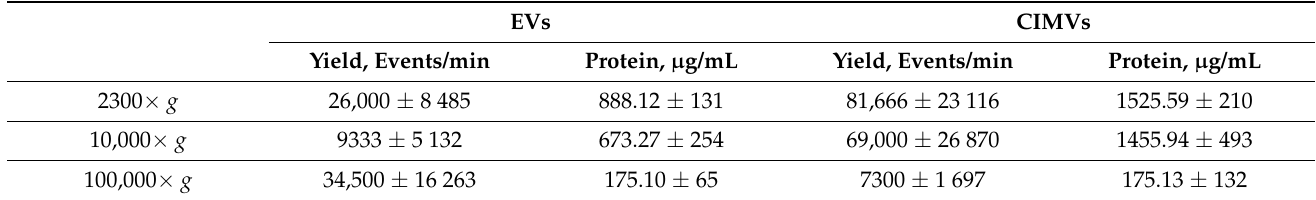
Table 1. Yield and protein concentration of EVs and CIMVs.